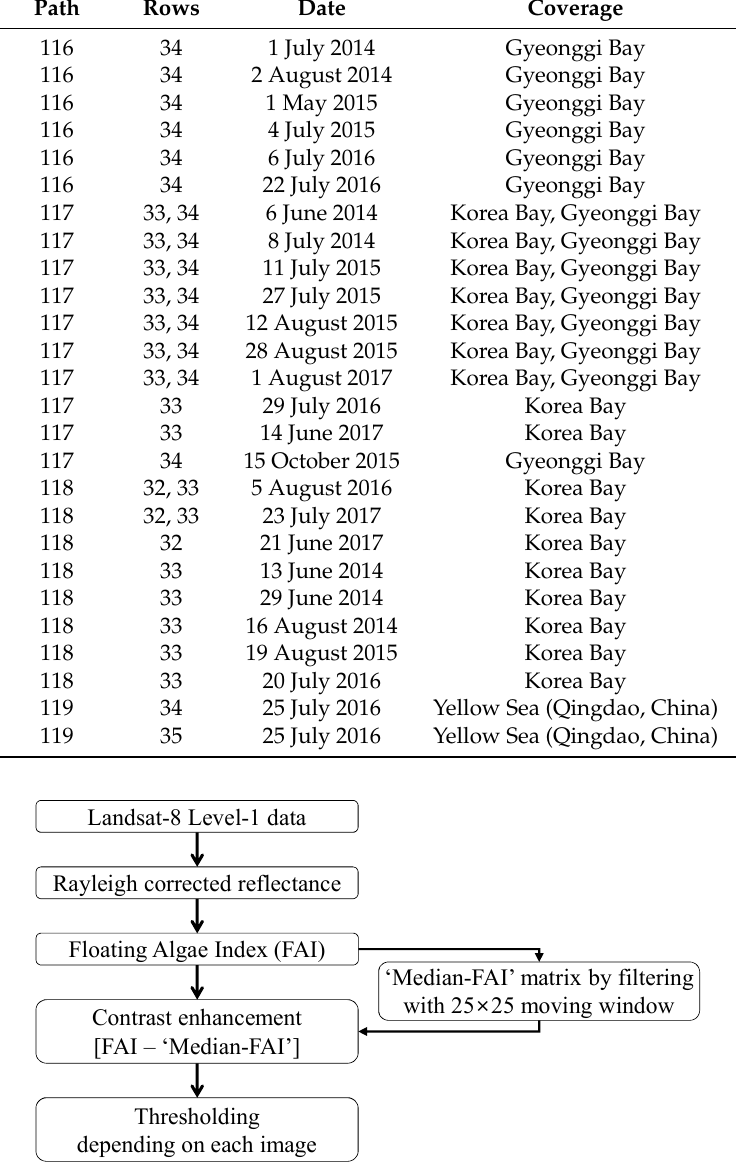
Table 1. List of Landsat-8 images used in this study.